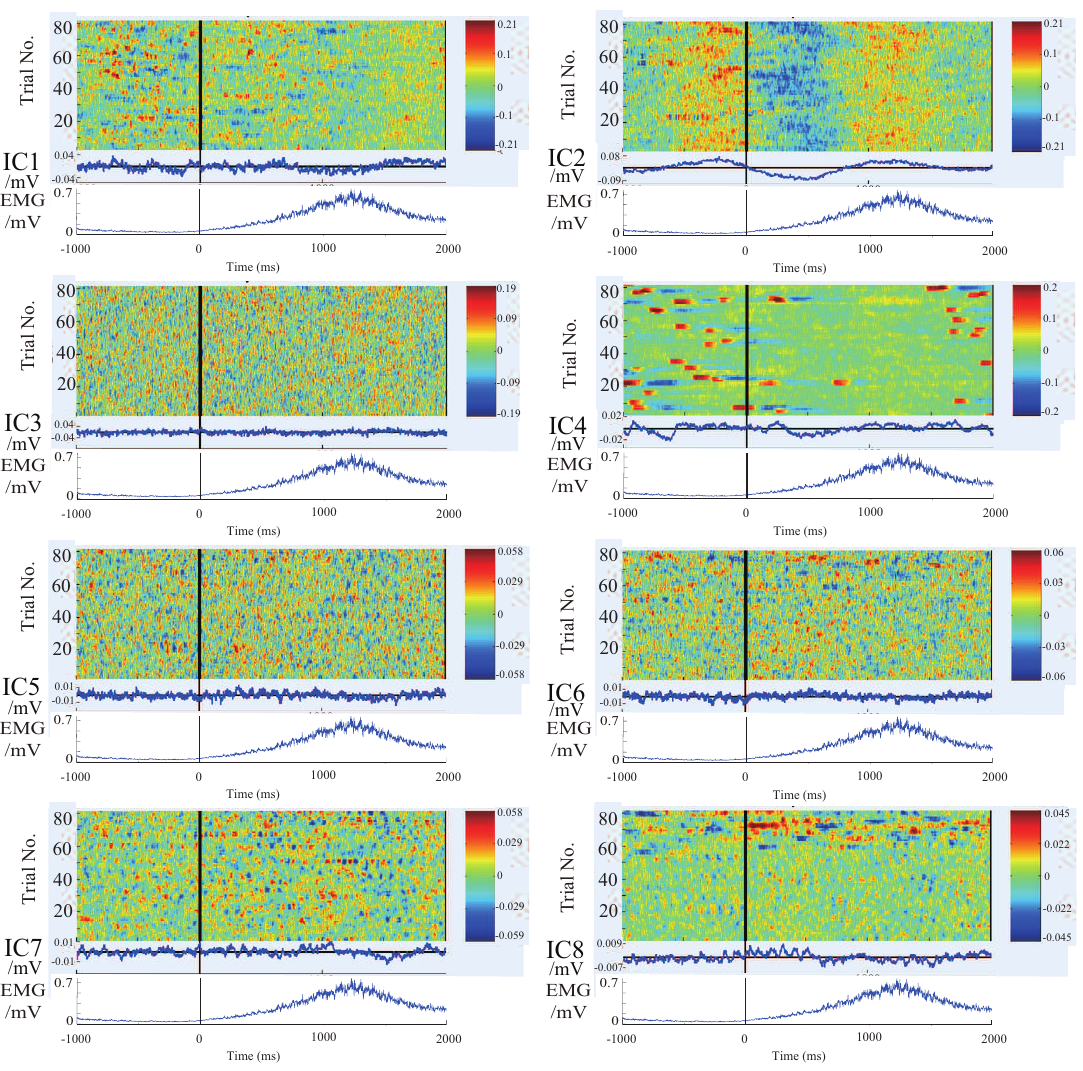
Figure 5. The waveform of each independent component in each experiment of subject B. 8 subpanels in the figure correspond to 8 independent components (IC1–IC8). The upper part of each subpanel shows the amplitude of the independent component restored to all trials at time series, which is plotted by color. The horizontal axis is time, and the black vertical line divides the 3-s data to 1 s before the motion and 2 s after the motion. The vertical axis is the number of trials. The IC part is an average value of EEG signals of all the waveforms produced by all the trials. The lower part is an average value of EMG signal of all the